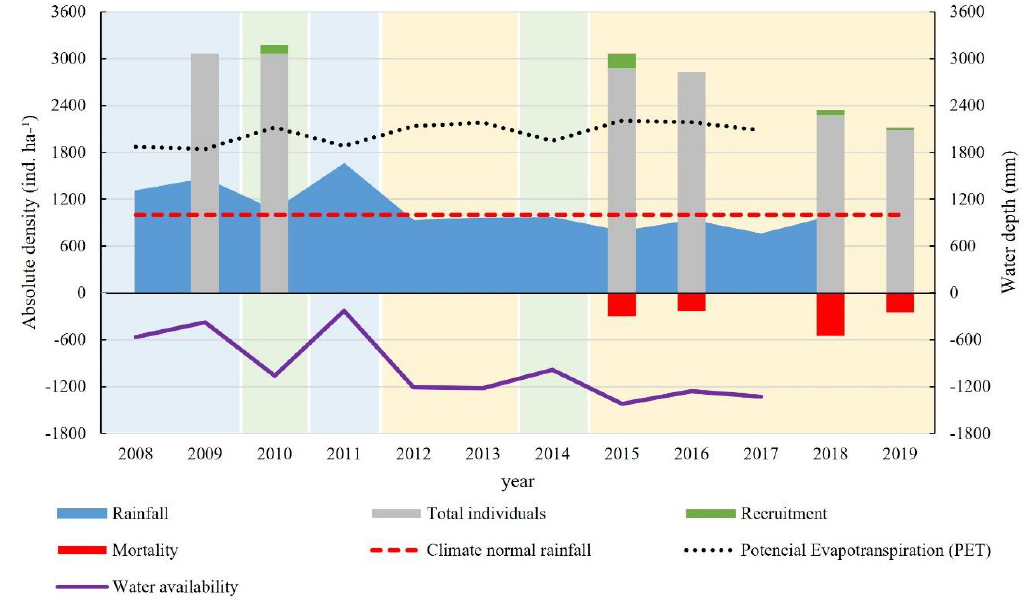
Figure 6. Annual distribution of tree density, recruitment, and mortality in a fragment of dry forest in the northeast of Brazil.